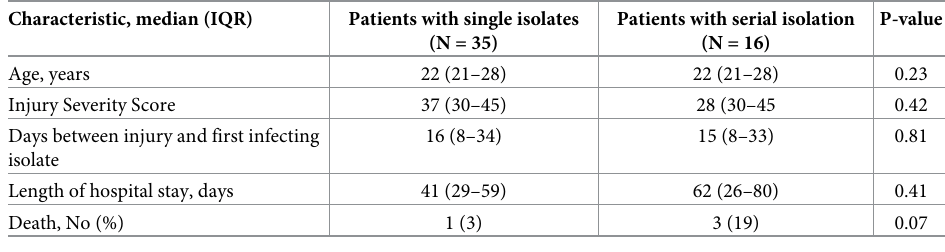
Table 2. Patients with serial isolation of Klebsiella spp. versus those with initial isolation only.